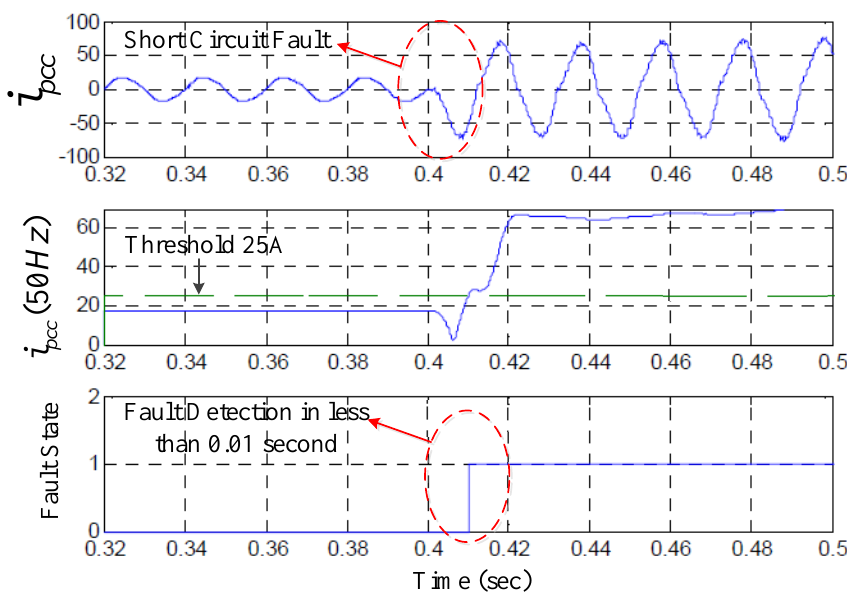
Figure 10. Boost converter diode short circuit fault.